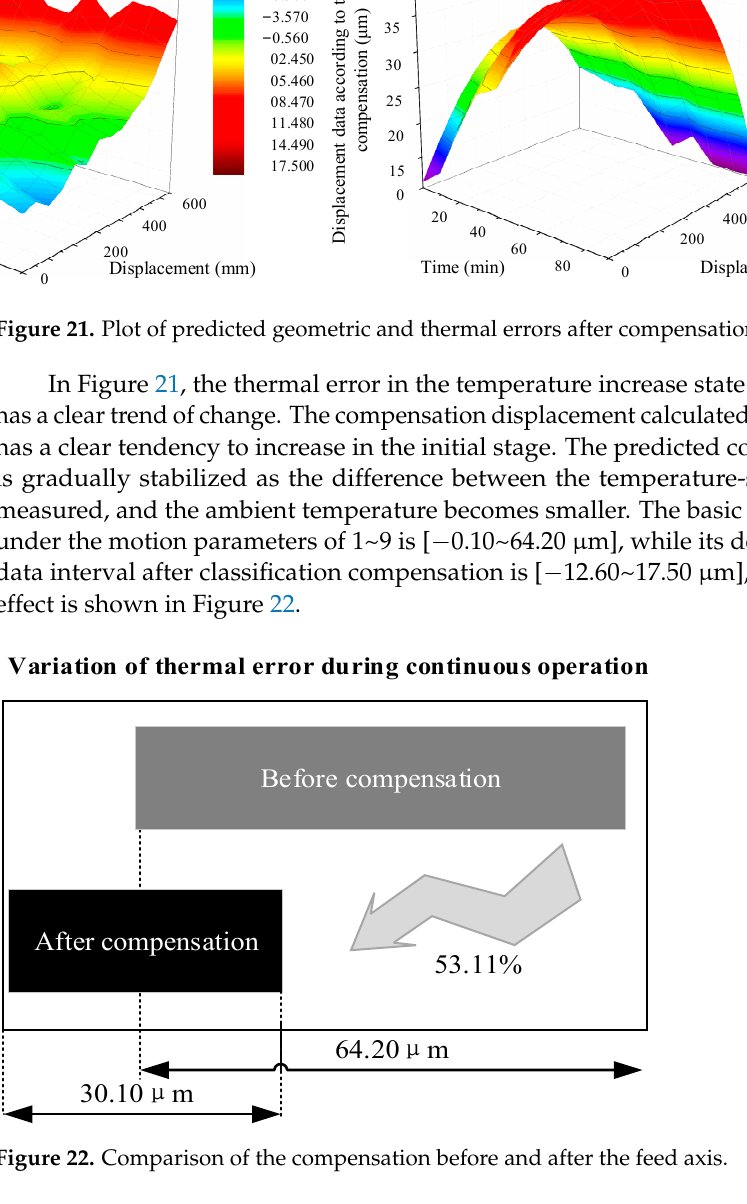
Figure 22. Comparison of the compensation before and after the feed axis.